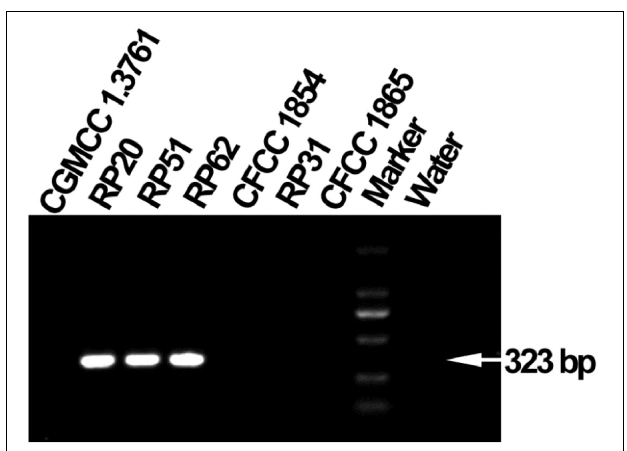
FIGURE 7 | Agarose gel electrophoresis shows PCR amplification of nifH gene fragments (323 bp) from P. peoriae strains RP20, RP51, and RP62 but not P. peoriae strain CGMCC 1.3761 T and CFCC 1854, Paenibacillus sp. RP31, and P. kribbensis CFCC1865.